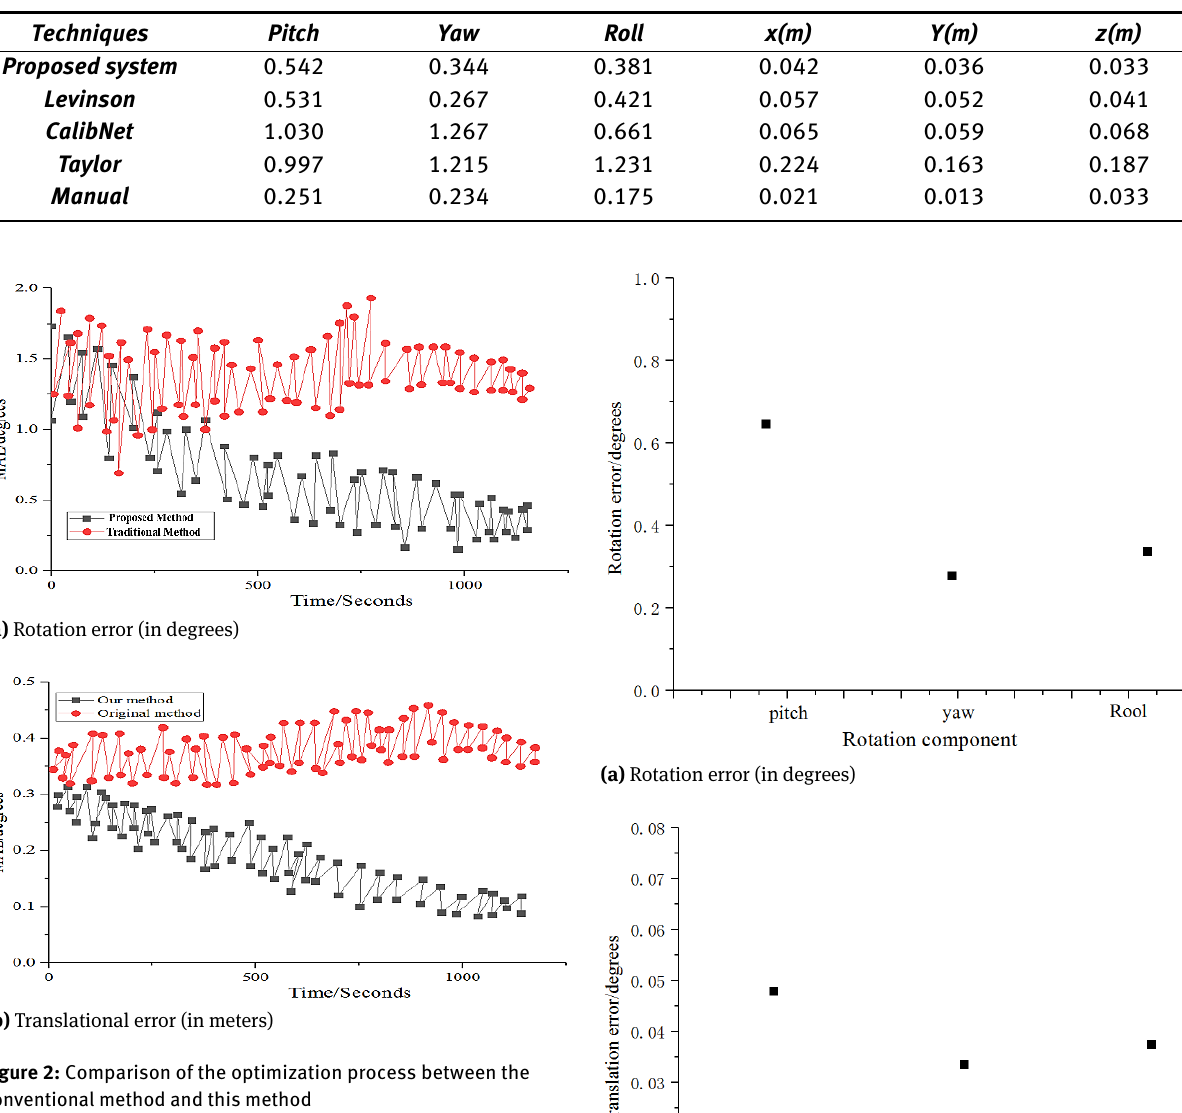
of the method in this paper are more balanced, and there is no outstanding error